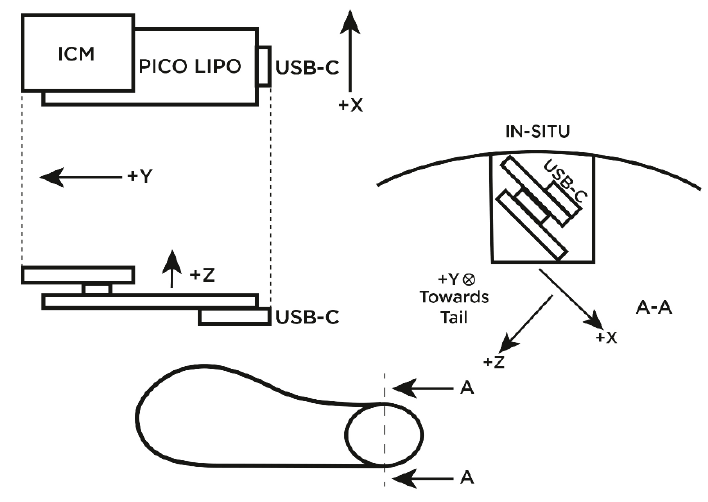
Figure 12. Schematic showing orientation of IMU axes relative to TA2.